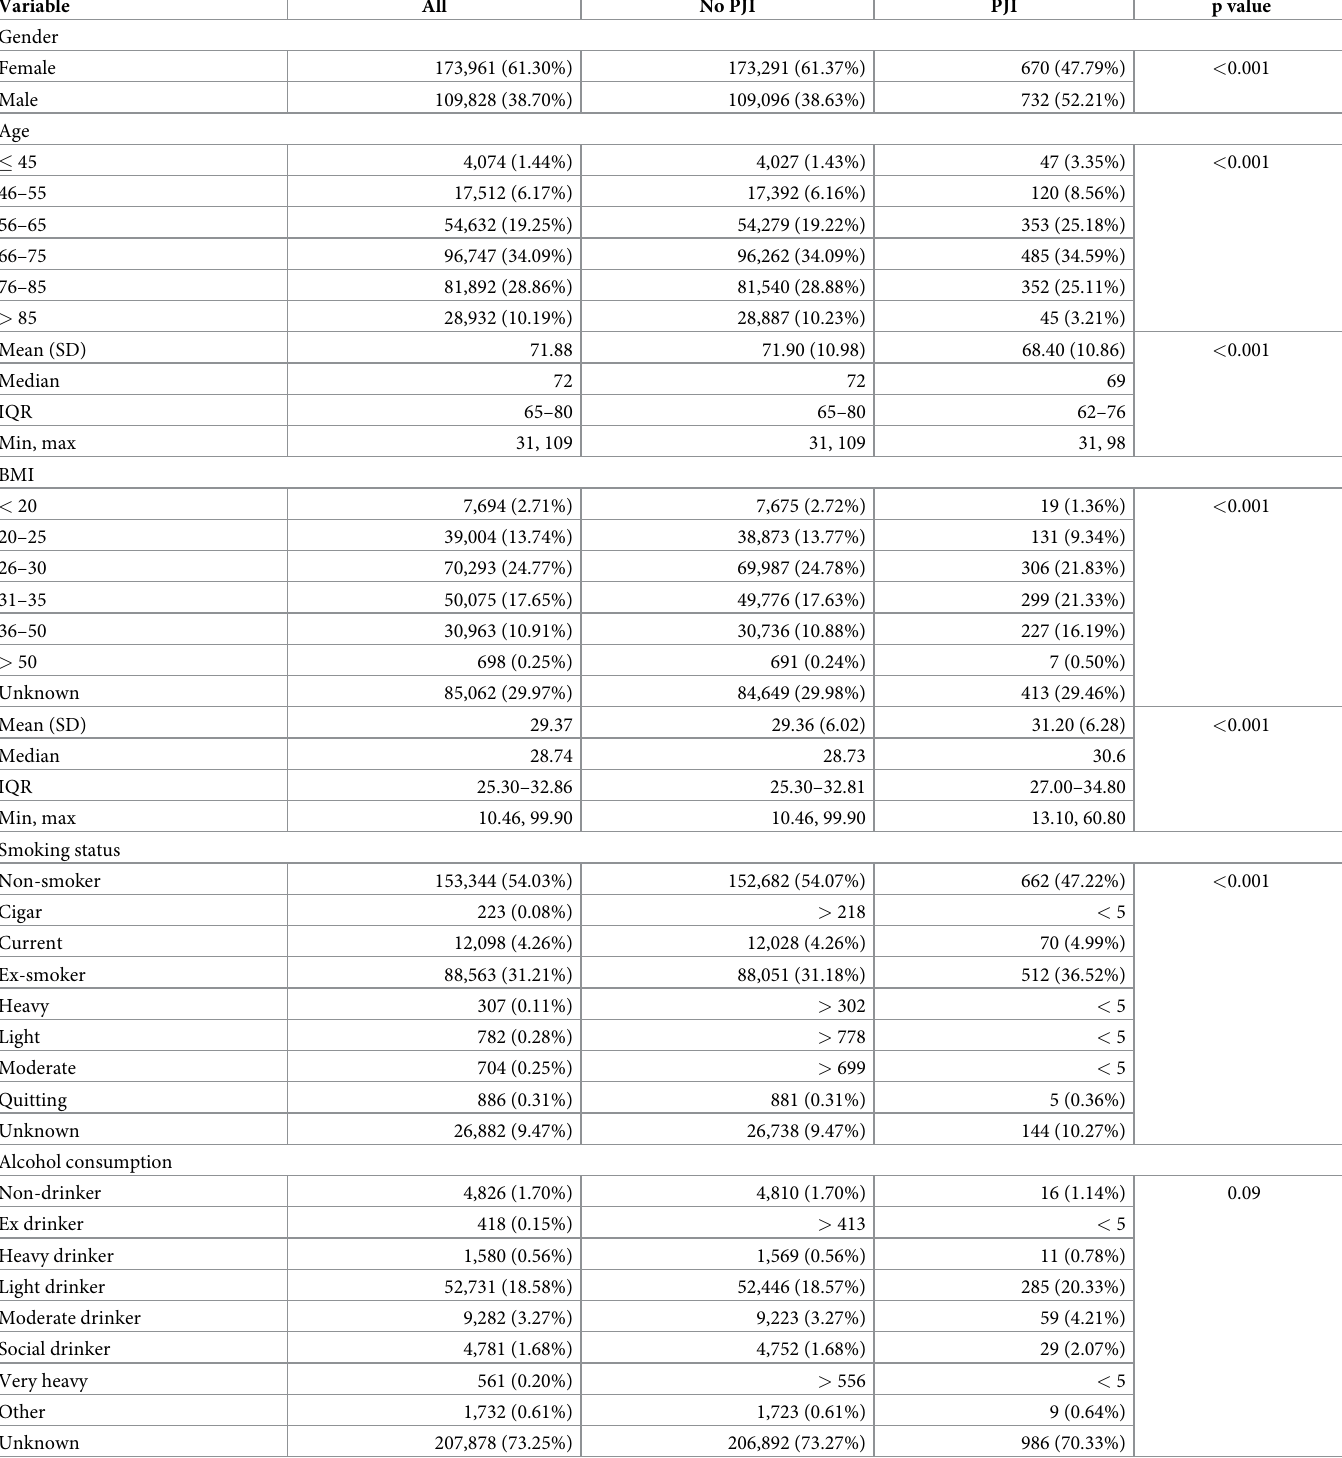
Table 1. Characteristics of patients at the time of hip or knee implant